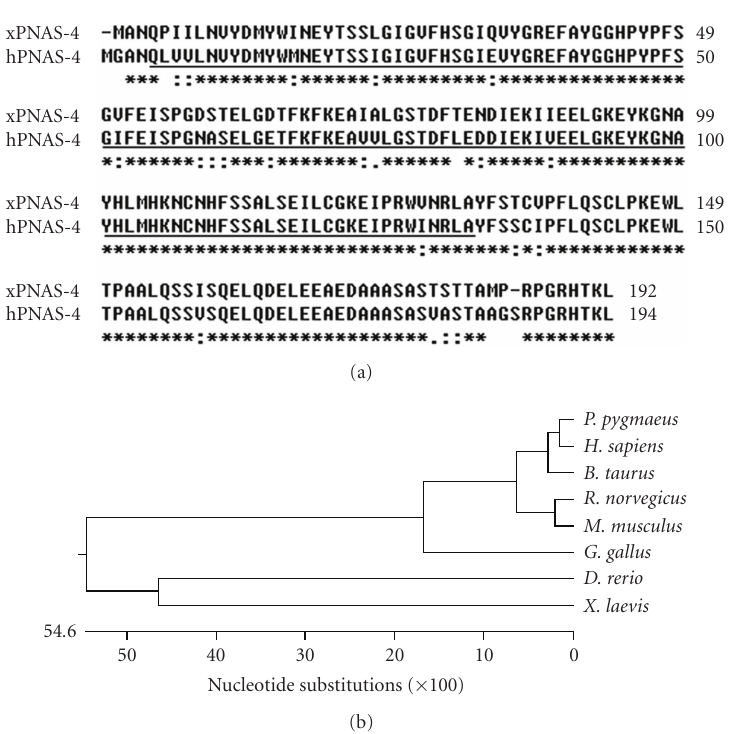
Figure 1: Comparison of the PNAS-4 protein sequence from X. laevis (GenBank protein id: AAH87412 ) with those of other species. (a) Alignment of xPNAS-4 and hPNAS-4 protein sequences (GenBank protein id: NP 057160 ) showing that they are homologous proteins. There is a DUF862 domain (underlined) in the hPNAS-4 and xPNAS-4 proteins. Asterisks ( ∗ ) indicate amino acid residues that are conserved across species. Colons (:) indicate strong similarity between protein xPNAS-4 and hPNAS-4. Dots ( · ) indicate weak similarity. (b) Phylogenetic tree of the PNAS-4 nucleotide